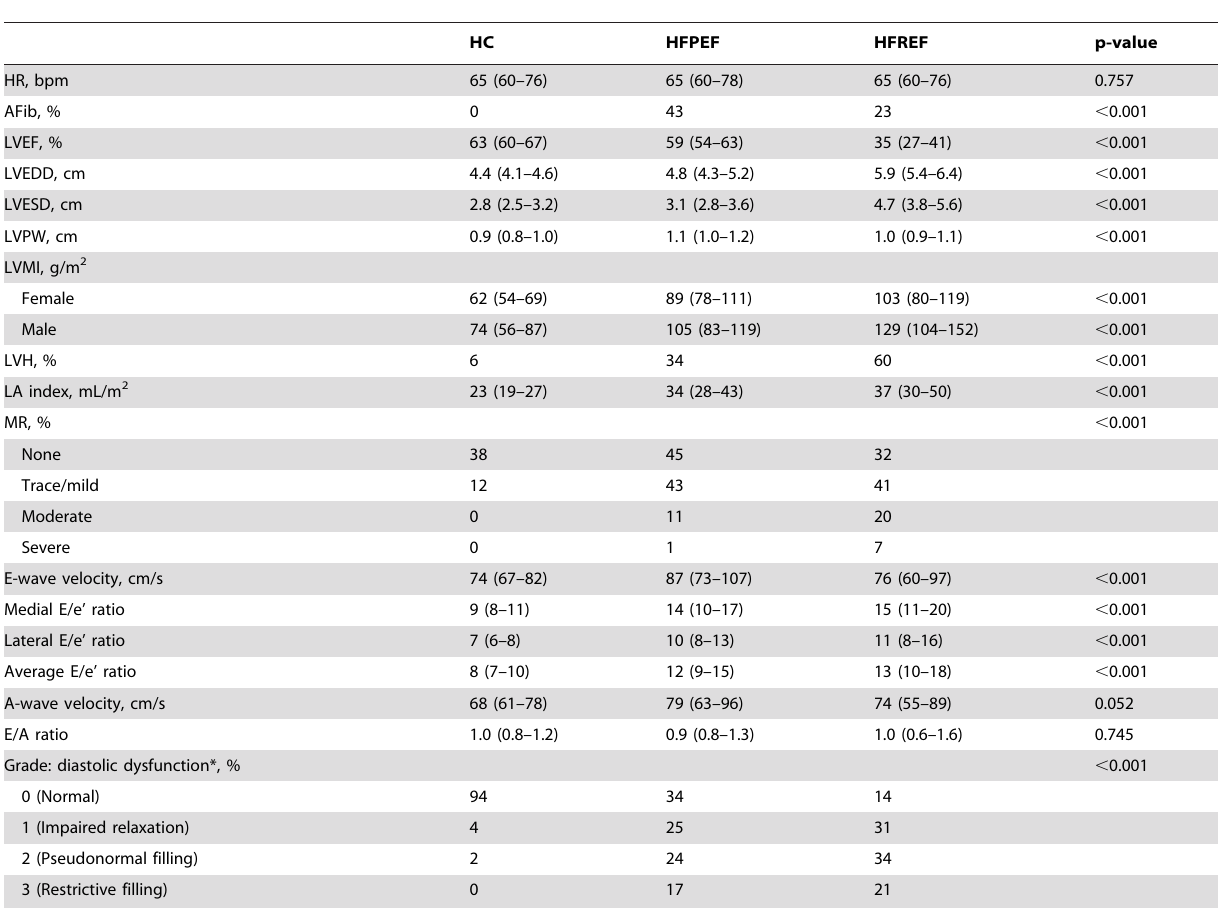
Table 2. Electrocardiogram and